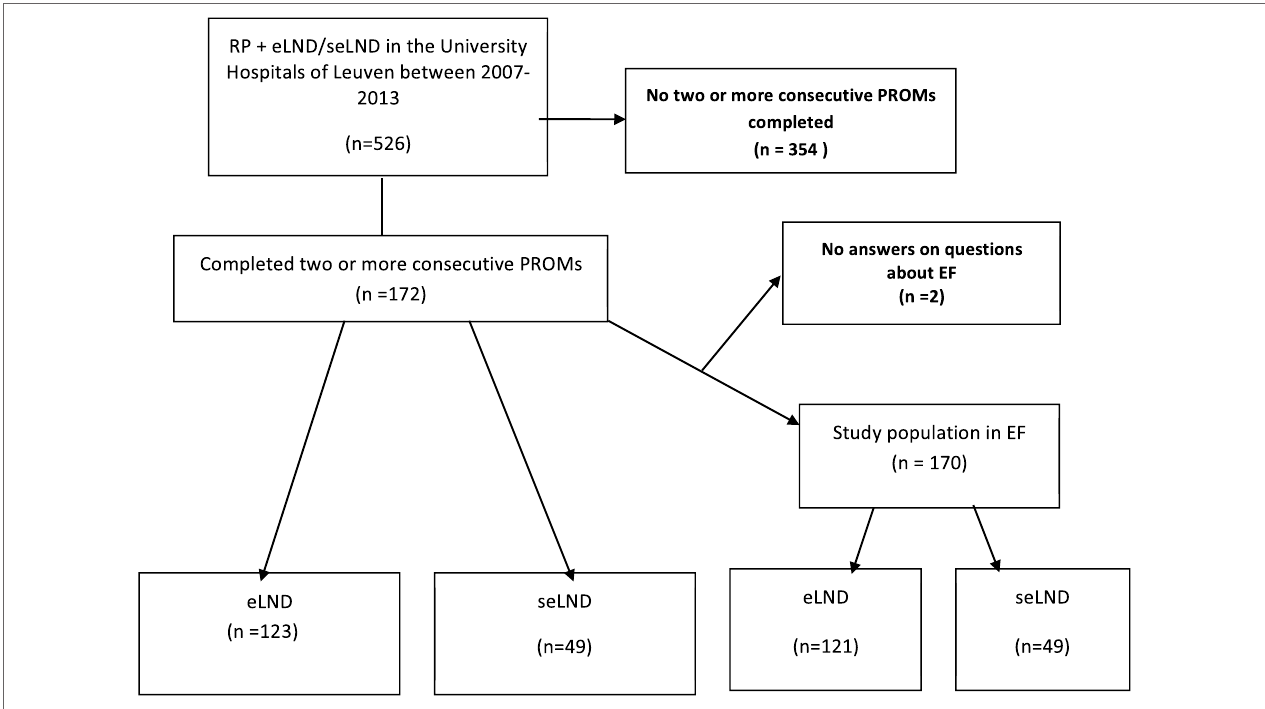
FigUre 1 | Flow diagram of the study population. RP, radical prostatectomy; eLND, extended lymph node dissection; seLND, super-extended lymph node dissection; EF, erectile function; PROM, patient reported